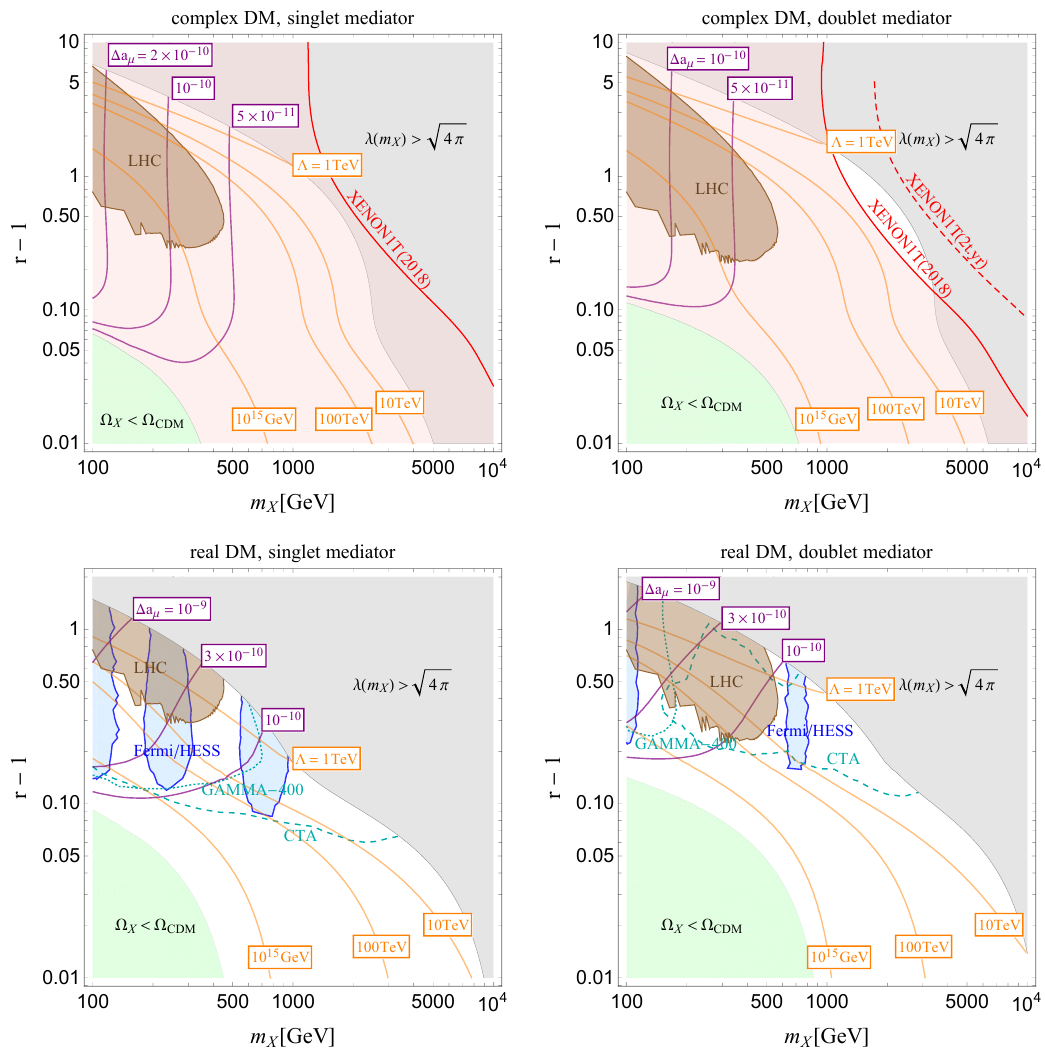
Figure 7 . Plots for the complex (top panels) and real (bottom panels) scalar DM. The vectorlike lepton is a weak singlet (left panels) or doublet (right panels). Direct detections of the DM at the XENON1T [107] excludes the red region. In the gray region on the upper corner, the DM thermal abundance requires a non-perturbatively large coupling (cid:21) > p 4 (cid:25) at the freeze-out. In the green L ( R ) region, coannihilation is too e(cid:14)cient to explain the thermal abundance observed at the Planck [30]. The orange contours stand for the Landau pole scales and the purple contours stand for (cid:1) a (cid:22) . The brown regions are excluded by the slepton searches at the LHC, where the limits are projected from (cid:12)gure 2. The shaded blue regions in the bottom panels are excluded by the current gamma line observations at the Fermi-LAT [108] and the HESS [109]. The cyan lines show the future sensitivity at the GAMAM-400 (dotted) [92] and the CTA (dashed) [93].